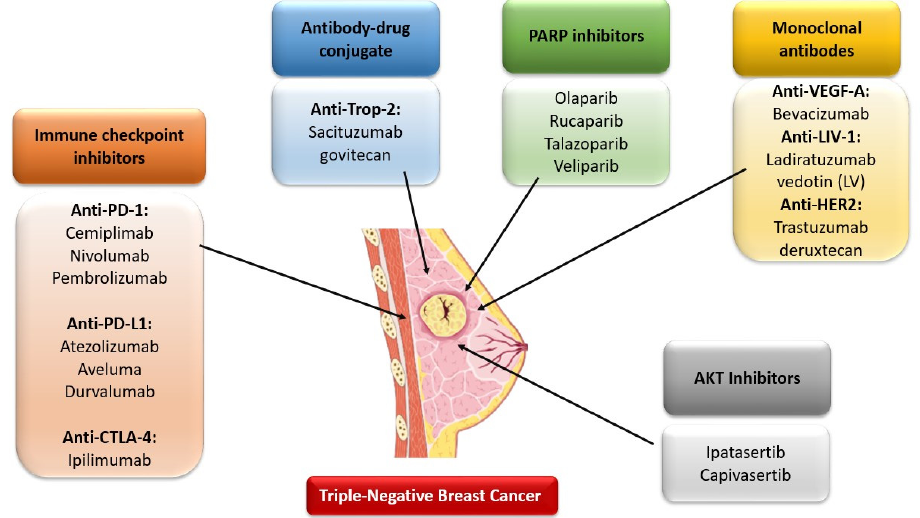
Figure 2. Drugs including immunotherapeutic agents that are currently being investigated in TNBC treatment [Own illustration designed on the basis of [8] ].